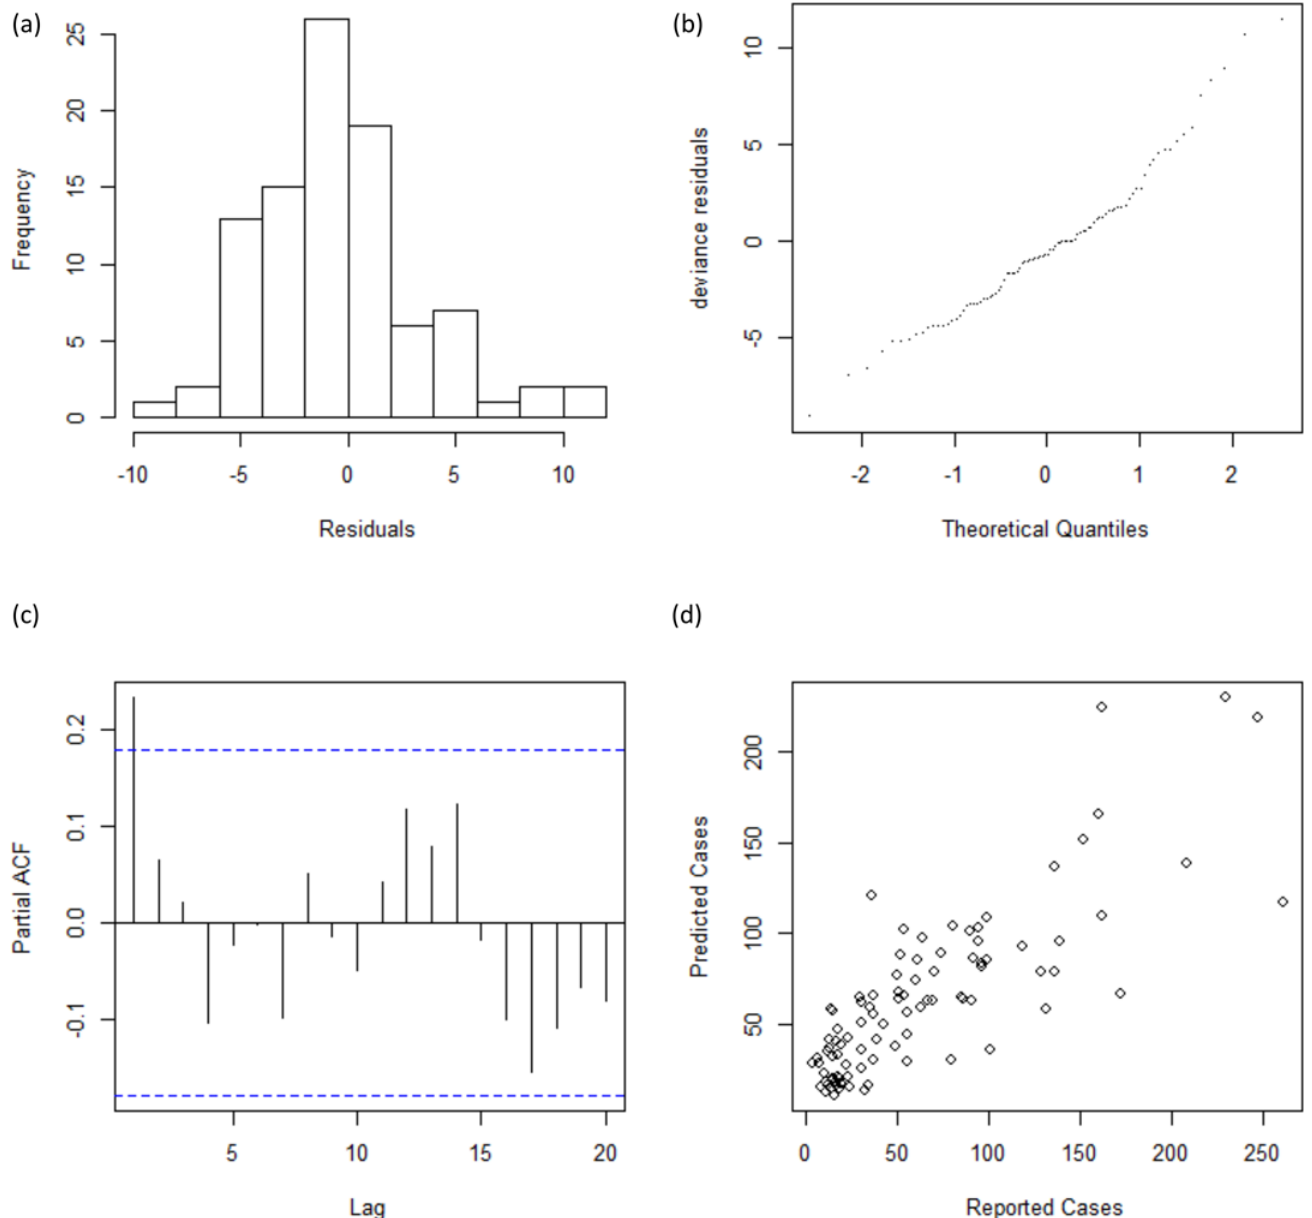
Fig 6. Residual Diagnosis. Upper panel shows (a) the residual histograms; and (b) the Q-Q plot for deviance residuals. Lower panel shows (c) the partial ACF plot; and (d) the relationship between reported and predicted